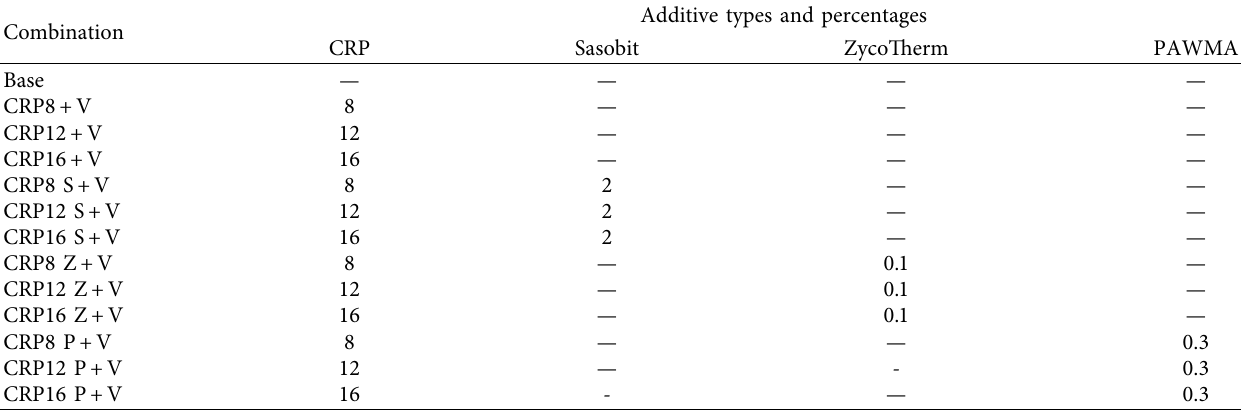
Table 3: The combinations of mixtures constructed.